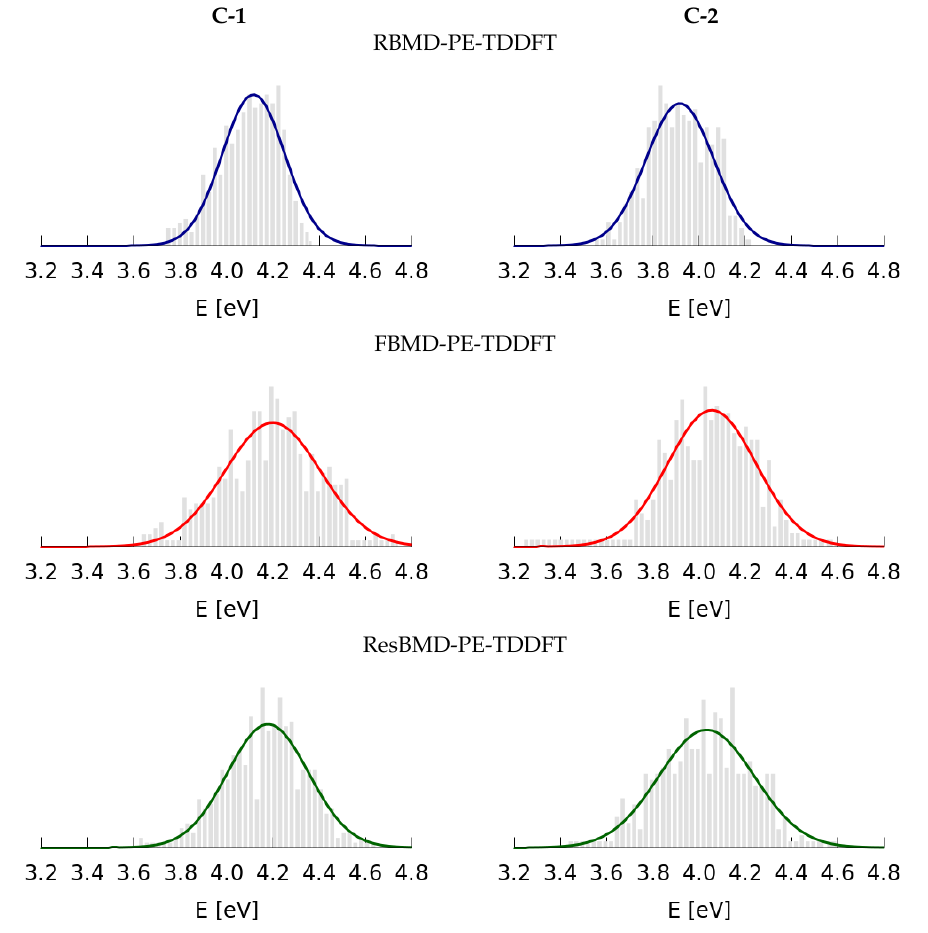
Figure 6. Histograms determined based on the results of calculations by using the RBMD-PE-TDDFT, FBMD-PE-TDDFT and ResBMD-PE-TDDFT approaches for uncorrelated C-1 ( left ) C-2 ( right )